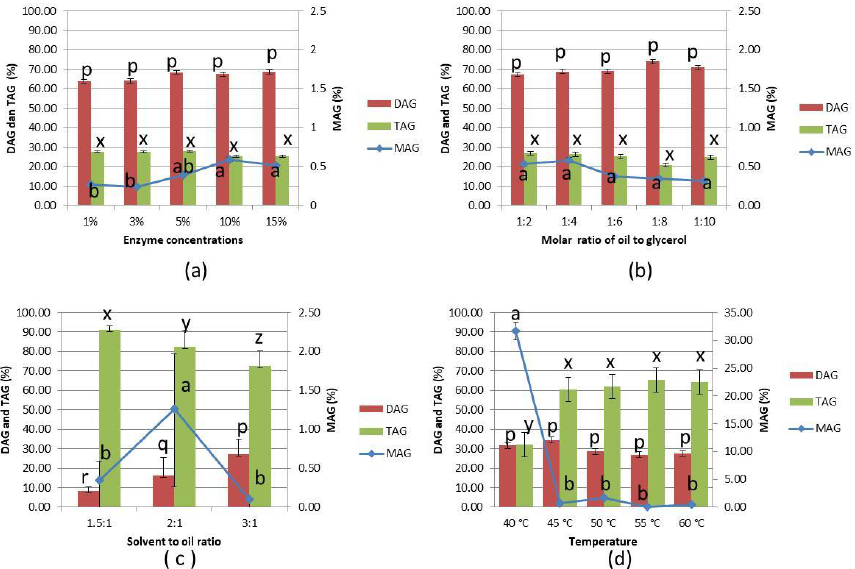
Figure 1. Composition of MAG, DAG, and TAG from the glycerolysis of PKOo-PKS blend at a ratio of 40:60 ( w / w ) for 24 h under various conditions: ( a ) enzyme concentration 1–15% w / w , molar ratio oil to glycerol of 1:4, stirring 200 rpm, tert-butanol to oil ratio of 1.5:1 v / w , temperature 50 ◦ C, ( b ) molar ratio oil to glycerol of 1:2 to 1:10, enzyme concentration 10%, stirring concentration 200 rpm, tert-butanol to oil ratio of 1.5:1 v / w , temperature 50 ◦ C, ( c ) solvent to oil ratio of 1.5:1 to 3:1 v / w , molar ratio oil to glycerol of 1:4, enzyme concentration 10%, stirring 200 rpm, temperature 50 ◦ C, and ( d ) temperature 40–60 ◦ C, molar ratio oil to glycerol of 1:4, enzyme concentration 10%, stirring 600 rpm, solvent to oil ratio of 2:1 v / w . Error bars refer to the standard deviations obtained from duplicate sample analysis in duplicate experiments. Means in the same indexes with different letters (a–d) differ significantly at p < 0.05 by Duncan’s multiple range